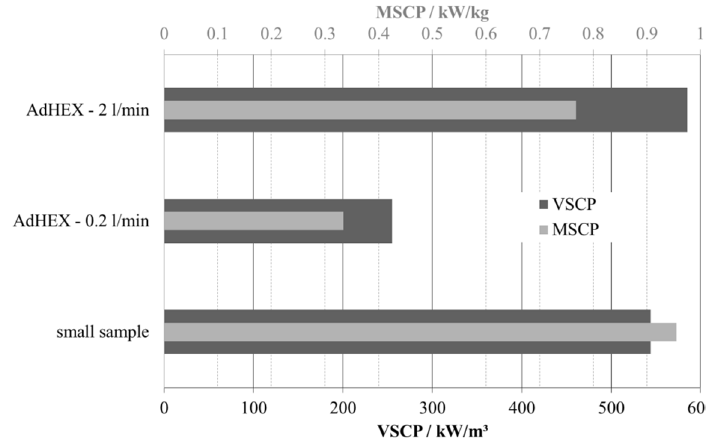
Figure 9. Mass-specific (MSCP) and volume-specific (VSCP) cooling power for the adsorption half-cycle calculated with 90% loading time of the composite material as a small sample and in an